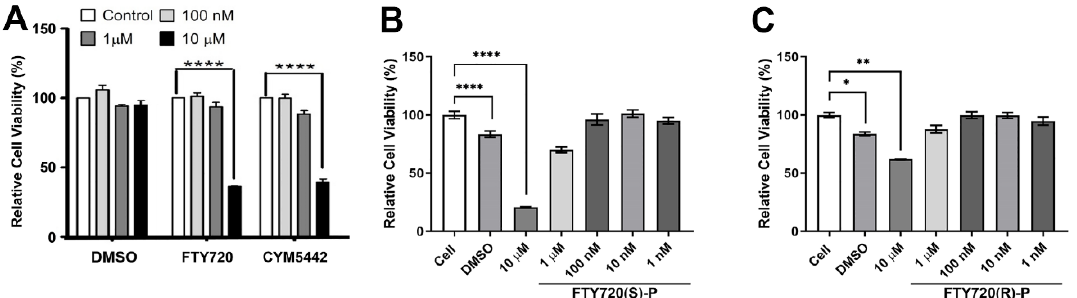
Figure 2. The S1PR non-selective agonist FTY720 and the S1PR1 selective agonist CYM5442 impact ChEC viability. ( A ) ChECs were grown in 96-well plates and incubated with medium containing varying concentrations of FTY720 or CYM5442 (in DMSO) or DMSO for 4 days. ( B , C ) ChECs were also incubated with different concentrations of active (FTY720(S)-P) or inactive (FTY720(R)-P) FTY720 enantiomers for 2 days. The percent cell viability relative to control samples was determined as described in Methods. * p < 0.05; ** p < 0.01, **** p < 0.0001. ( n = 3).